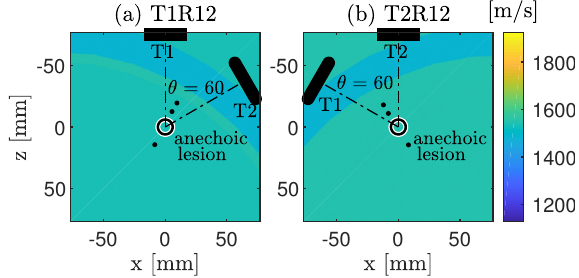
Figure 2. Example of the speed of sound map of a propagation medium with a muscle layer of 8 mm and a fat layer of 25 mm in thickness. Locations of US probes, point-like targets and anechoic lesion are shown. ( a ) Medium expressed in the local coordinate system of the array T1 and used to simulate the RF data T1R12, i.e., when the array T1 transmits. ( b ) Medium expressed in the local coordinate system of the array T2 and used to simulate the RF data T2R12, i.e., when the array T2 transmits. In this example, the angle between the probes that defines their position in space is 60 ◦ and the corresponding imaging depth 75